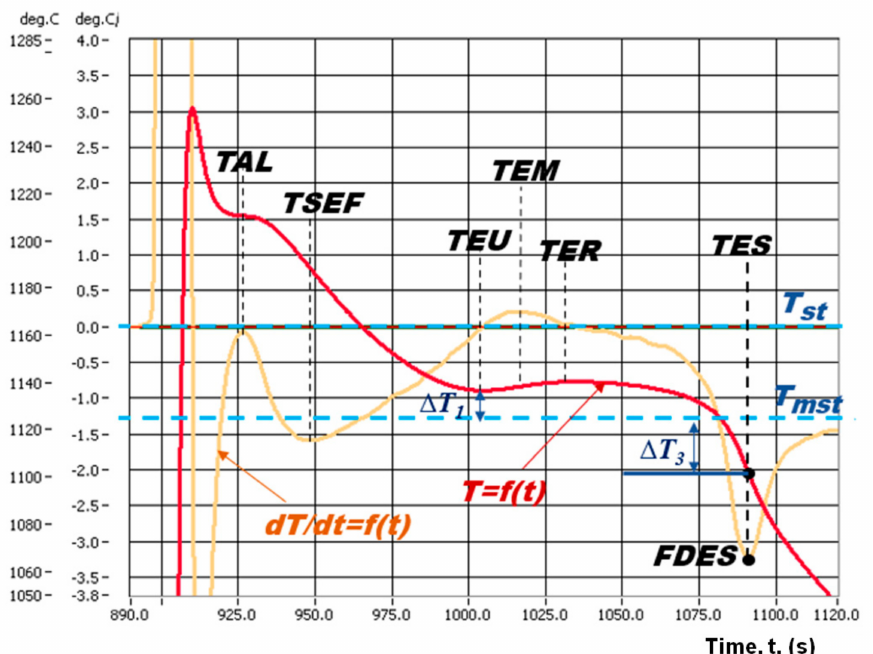
Figure 8. Typical cooling curve-first derivative curve assembly with representative parameters of 0.25 (wt.%) Ce,Ca-FeSi inoculated grey cast iron.